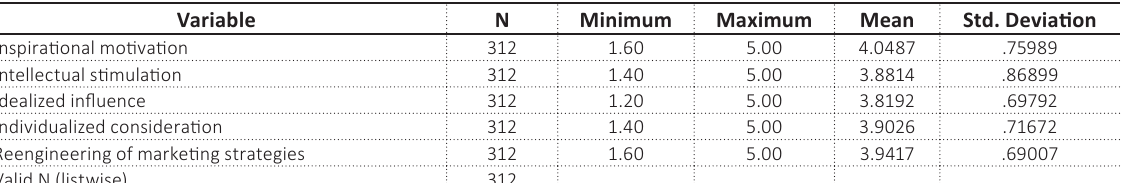
Table 3. Descriptive statistics